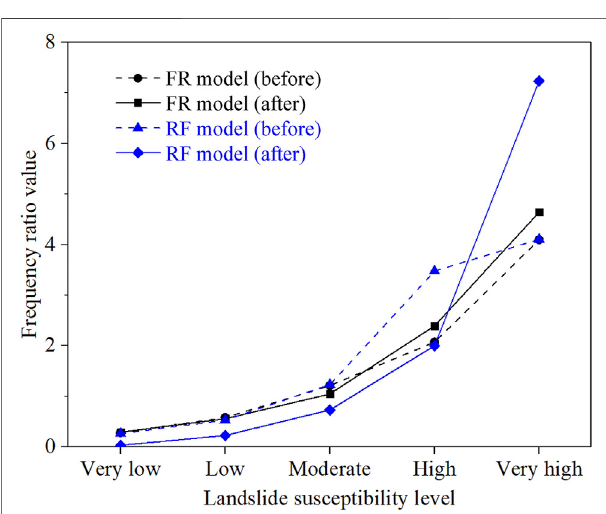
FIGURE 7 | Landslide frequency ratio for each susceptibility